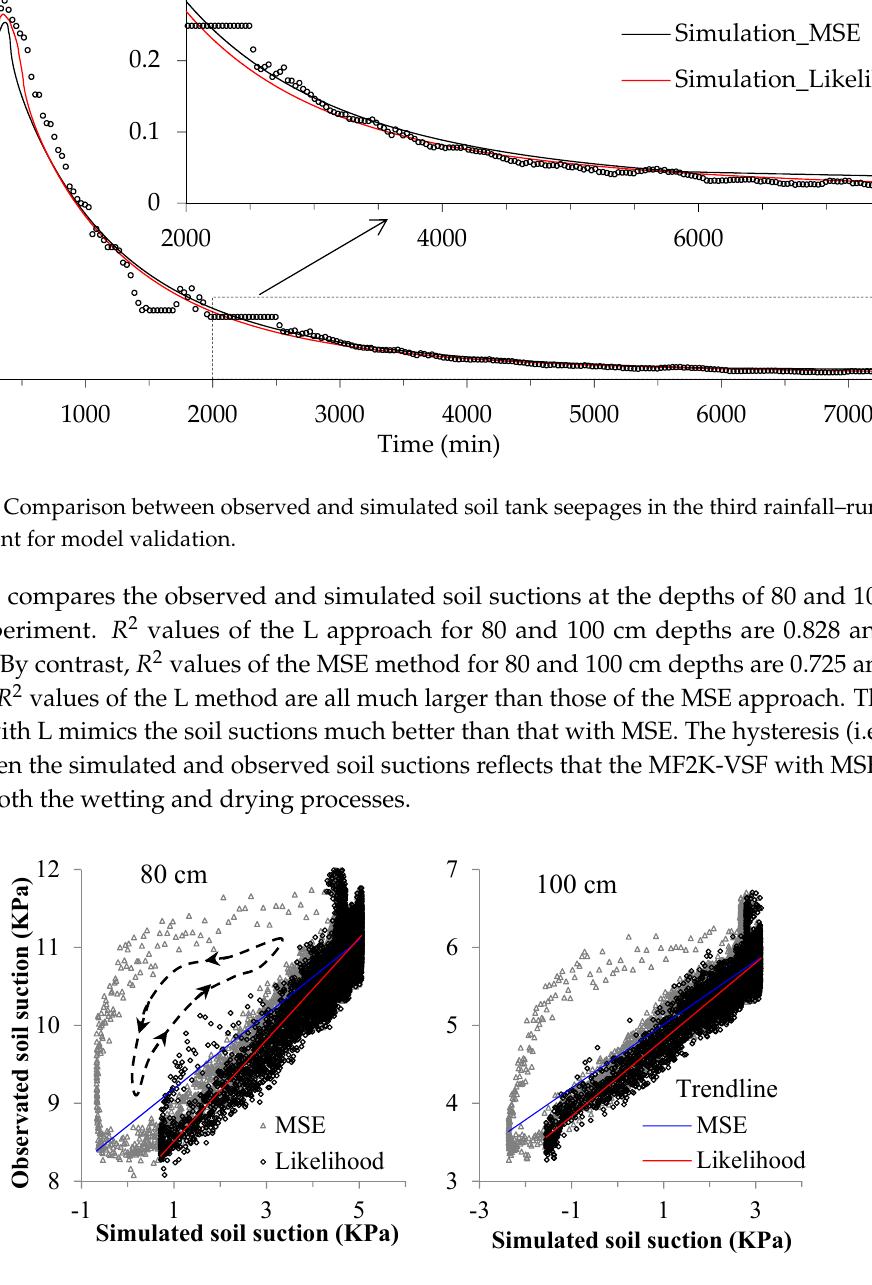
Figure 9. The observed soil suctions versus the simulations at the depths of 80 and 100 cm in the third rainfall–runoff experiment.